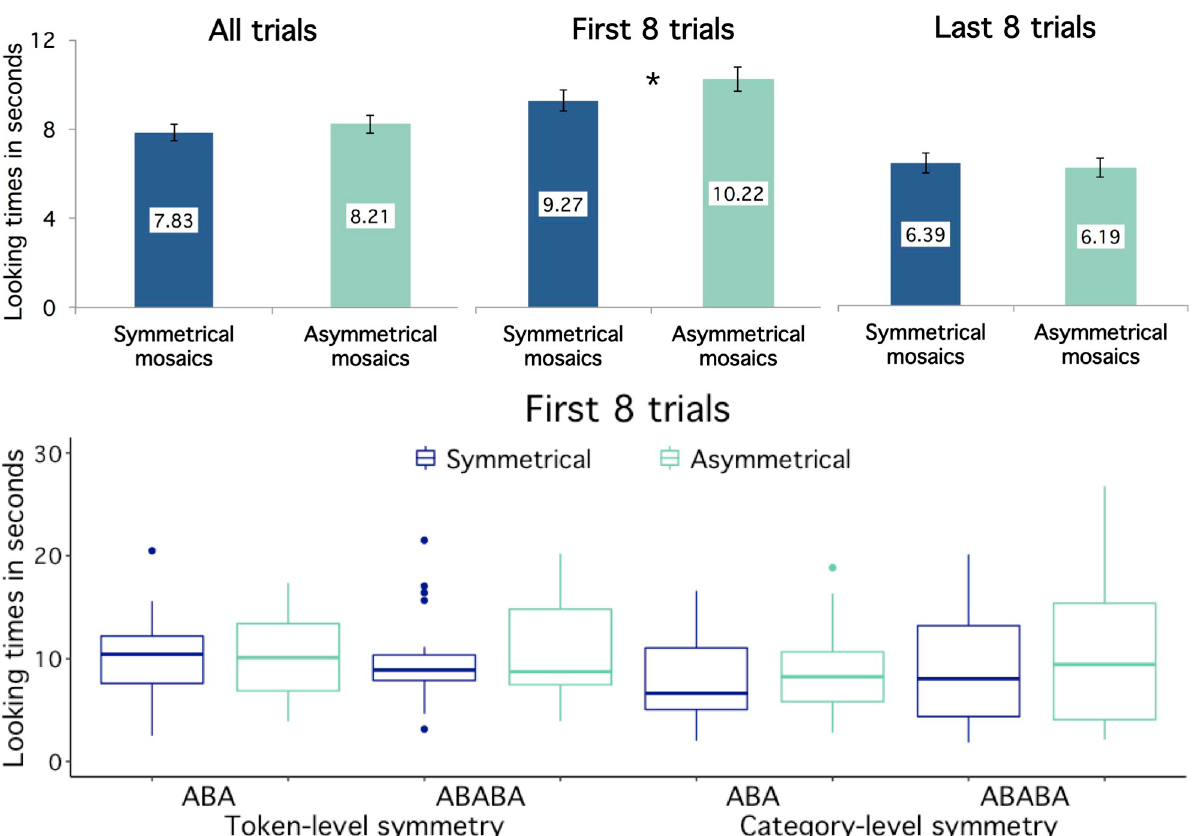
Fig 3. Looking time results. The upper bar plot shows infants’ mean looking times to the mosaics: during the 16 trials (left), in the first 8 trials (centre), and in the last 8 trials (right). Looking times in all 4 conditions (i.e. to 3- and 5-tiled mosaics, with token- and category-level structural symmetry) are collapsed. The y-axis displays the infants’ looking times in seconds. Dark blue bars depict mean looking times to structurally symmetrical mosaics, while light aquamarine bars display mean looking times to structurally asymmetrical mosaics. Error bars represent the standard error of the mean, and statistically significant comparisons are marked with an asterisk. The lower box-and-whisker plot depicts the distribution of infants’ mean looking times per condition during the first 8 trials.